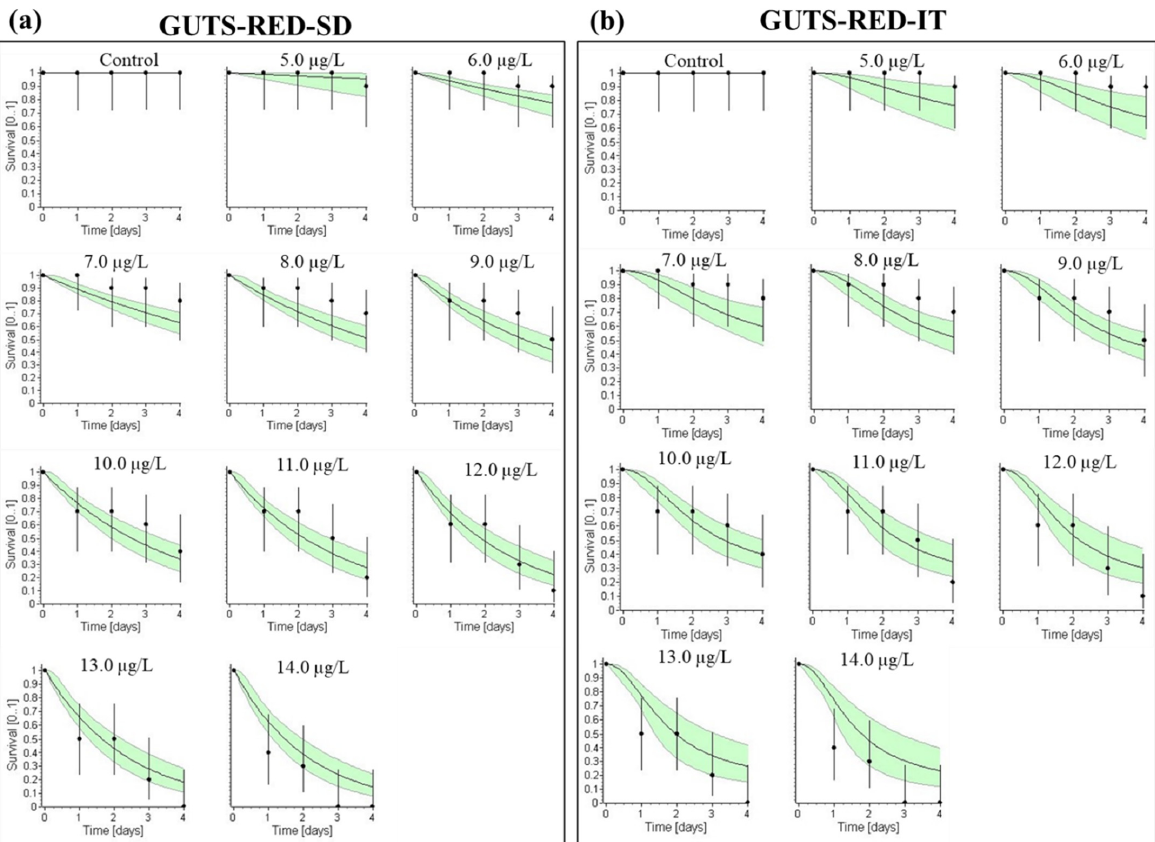
Figure 2. Relative fit of observed and fitted values of the ( a ) GUTS-SD and ( b ) IT models at different deltamethrin exposure concentrations .